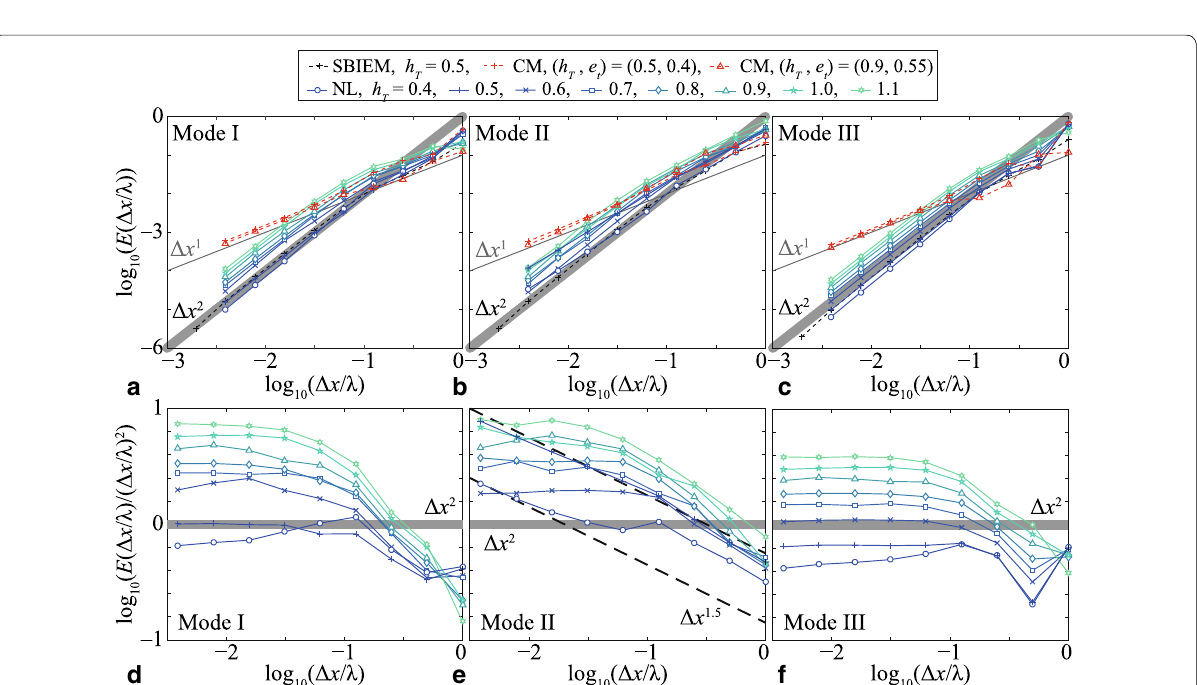
Fig. 8 The results of the convergence tests. a – c Estimated numerical error E (cid:31) (cid:31) x (cid:30) (cid:31) (cid:29) as a function of the element size (cid:31) x (cid:31) (cid:31) . Red symbols represent cases with CM. Green to blue symbols are for cases with NL with various h T . Black pluses are cases with the SBIEM. d – f The cases with NL normalized by (cid:31) (cid:31) x (cid:30) (cid:31) (cid:29) 2 . Panels in the left, center, and right columns represent Modes I, II, and III,